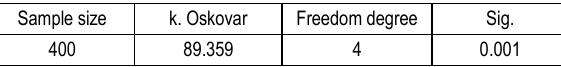
Table 15. Results of Friedman test (trust factors)